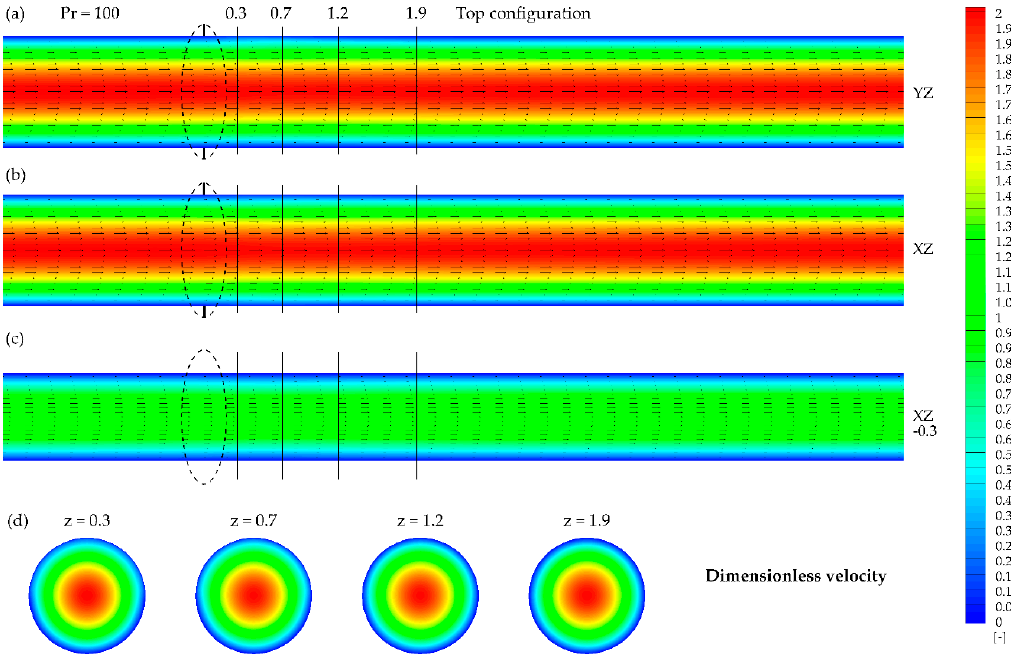
Figure 10. Dimensionless velocity contours and vectors obtained for Pr = 100 and top configuration in the presence of the magnetic field at: ( a ) YZ plane, ( b ) XZ plane, ( c ) XZ plane ( y = − 0.3), ( d ) XY planes at given z .